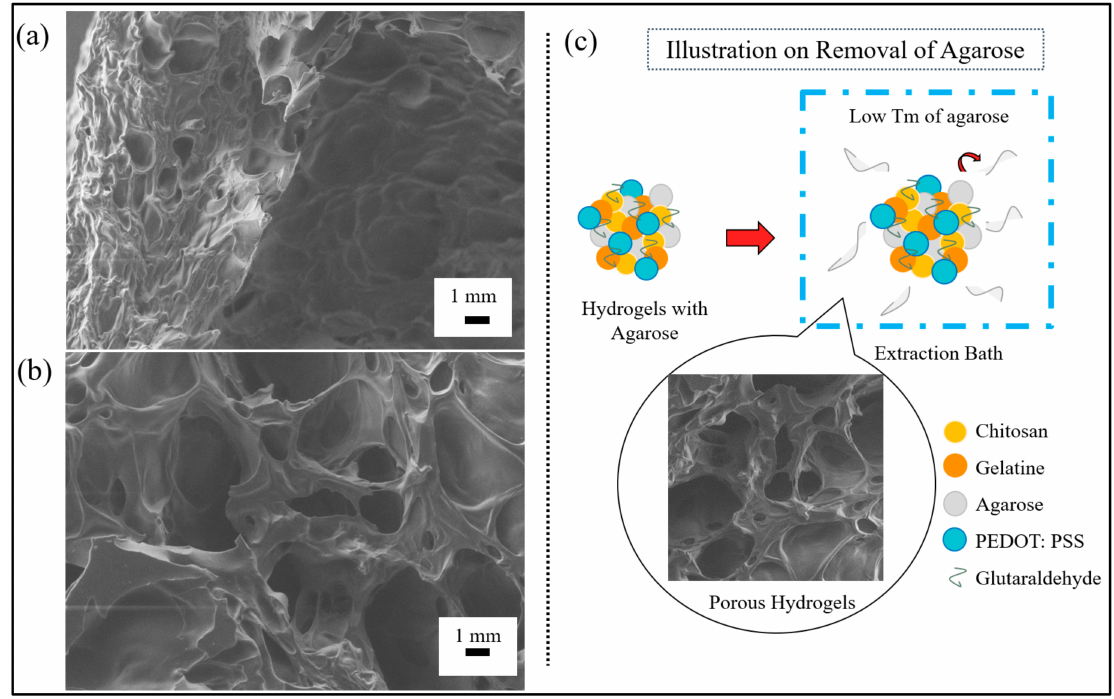
Figure 2. SEM micrographs of a porous hydrogel’s ( a ) outer layer structure and ( b ) inner layer structure. ( c ) An illustration of hydrogels undergoing the removal of